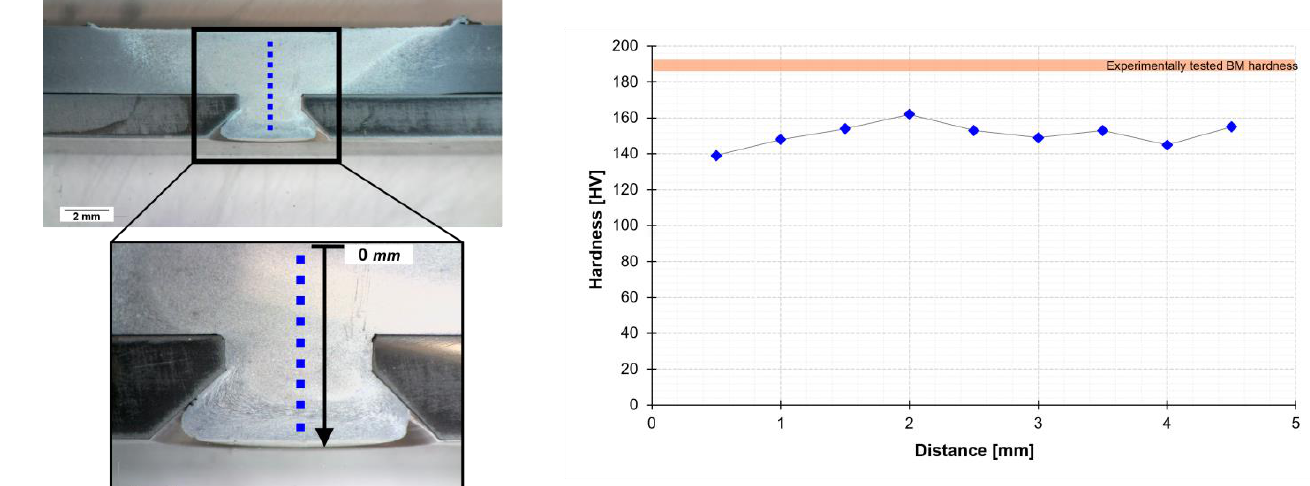
Figure 8. Cross-sectional view of joint E1, with the identification of the measured distance in the microhardness test and the plotted results of the tested line. Blue dots represent the testing locations while the black arrow corresponds to the reference of the testing path.